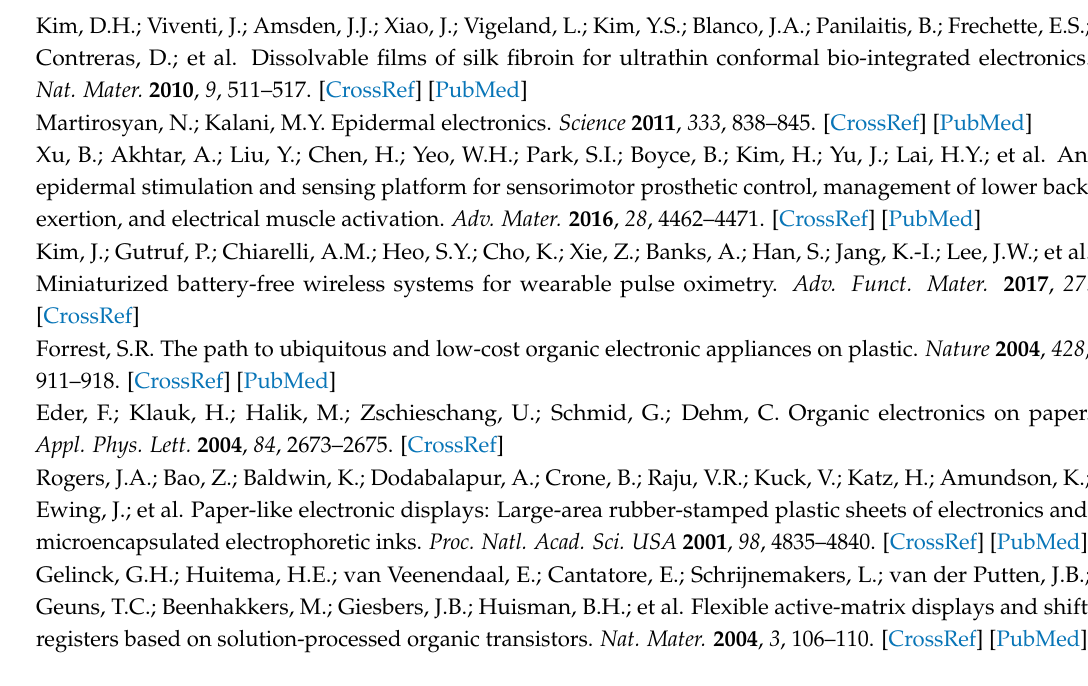
Figure S1: Dependence of the capacitance with frequency of the PVA dielectric layer spun from solution of different concentrations (3 wt %, 6 wt %, 8 wt %, and 10 wt %), Figure S2: The cross-sectional SEM image of the device. The red line indicates the “S/D electrode (20 nm) + C8-BTBT (~20 nm)” layer and the yellow line indicates the PVA layer (~280 nm) with embedded gate electrodes, Figure S3: (a) Transfer curves swept in backward and forward directions of C8-BTBT OTFTs on PVA dielectric layer, Figure S4: (a–d) The transfer characteristics of C8-BTBT OTFTs on PVA dielectric layer spun from solution of different concentrations (3 wt %, 6 wt %, 8 wt %, and 10 wt %), Figure S5: (a1–a4) AFM images of C8-BTBT films on corresponding PVA films spun from different concentrations (3 wt %, 6 wt %, 8 wt %, and 10 wt